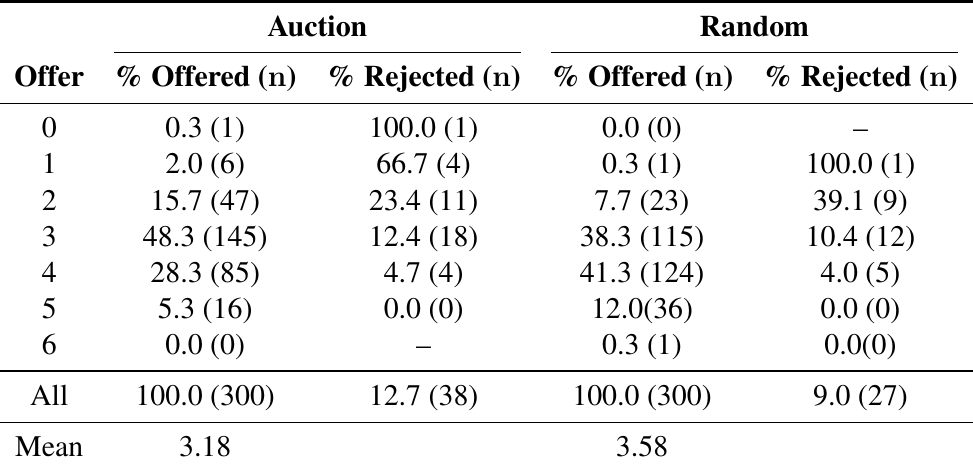
Table 2. Gross offer distributions, conditional rejection rates, and basic